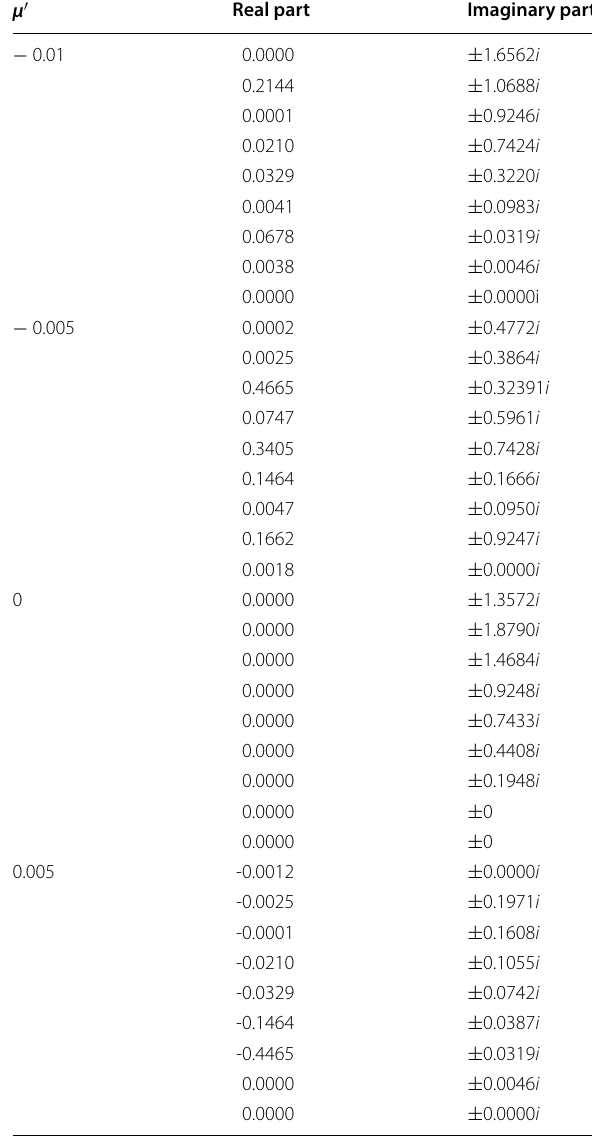
Table 2 Stability analysis results of different friction coefficient